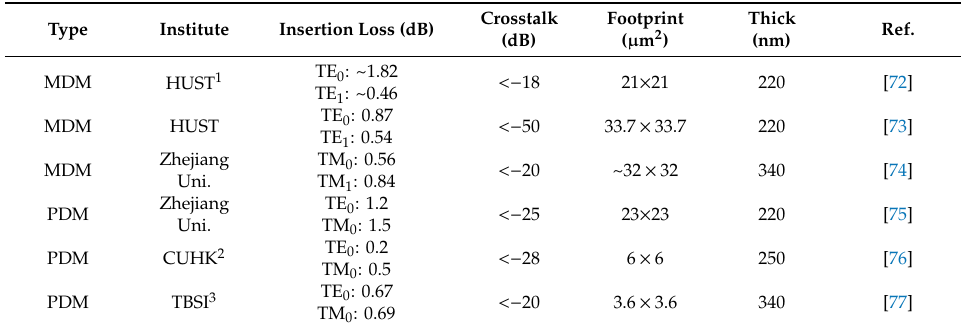
Table 2. Comparisons of silicon crossing with mode-division-multiplexing (MDM) and polarization-division-multiplexing (PDM)